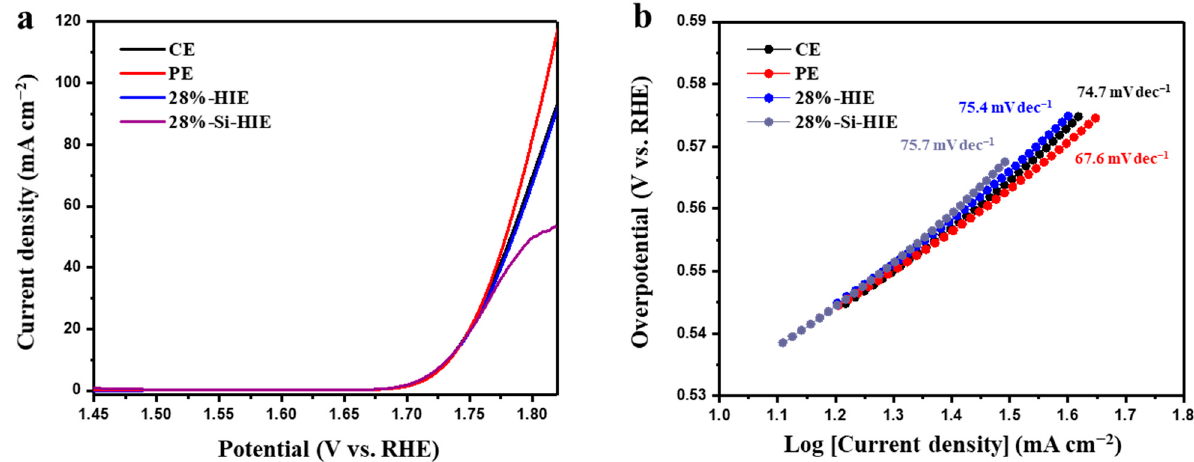
Figure 4. ( a ) Polarization curves for electrochemical OER activity and ( b ) the corresponding Tafel plots of CE, PE, 28%-HIE and 28%-Si-HIE.